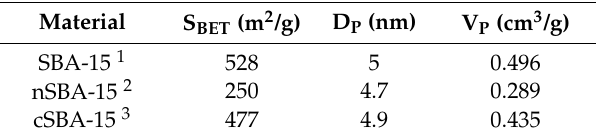
Table 1 . Textural characteristics of SBA-15 mesoporous drug nanocarriers (S BET —specific surface area,